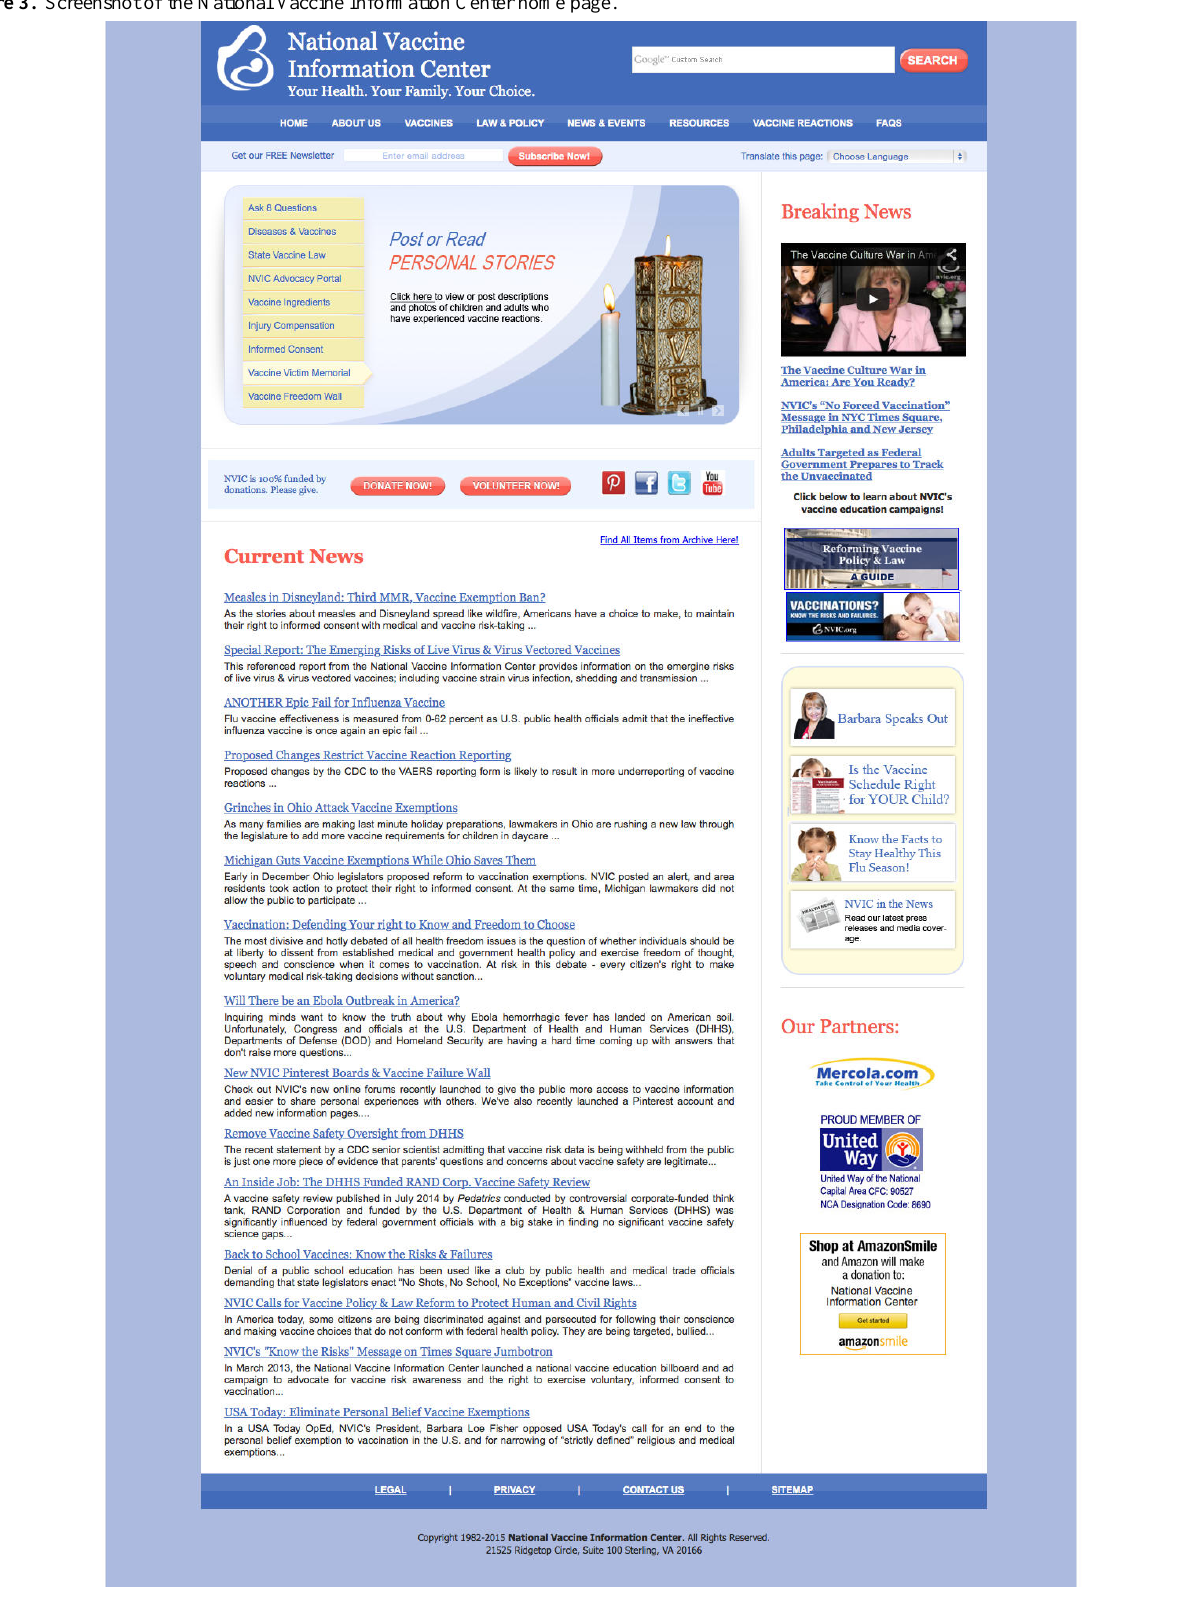
Figure 3. Screenshot of the National Vaccine Information Center home